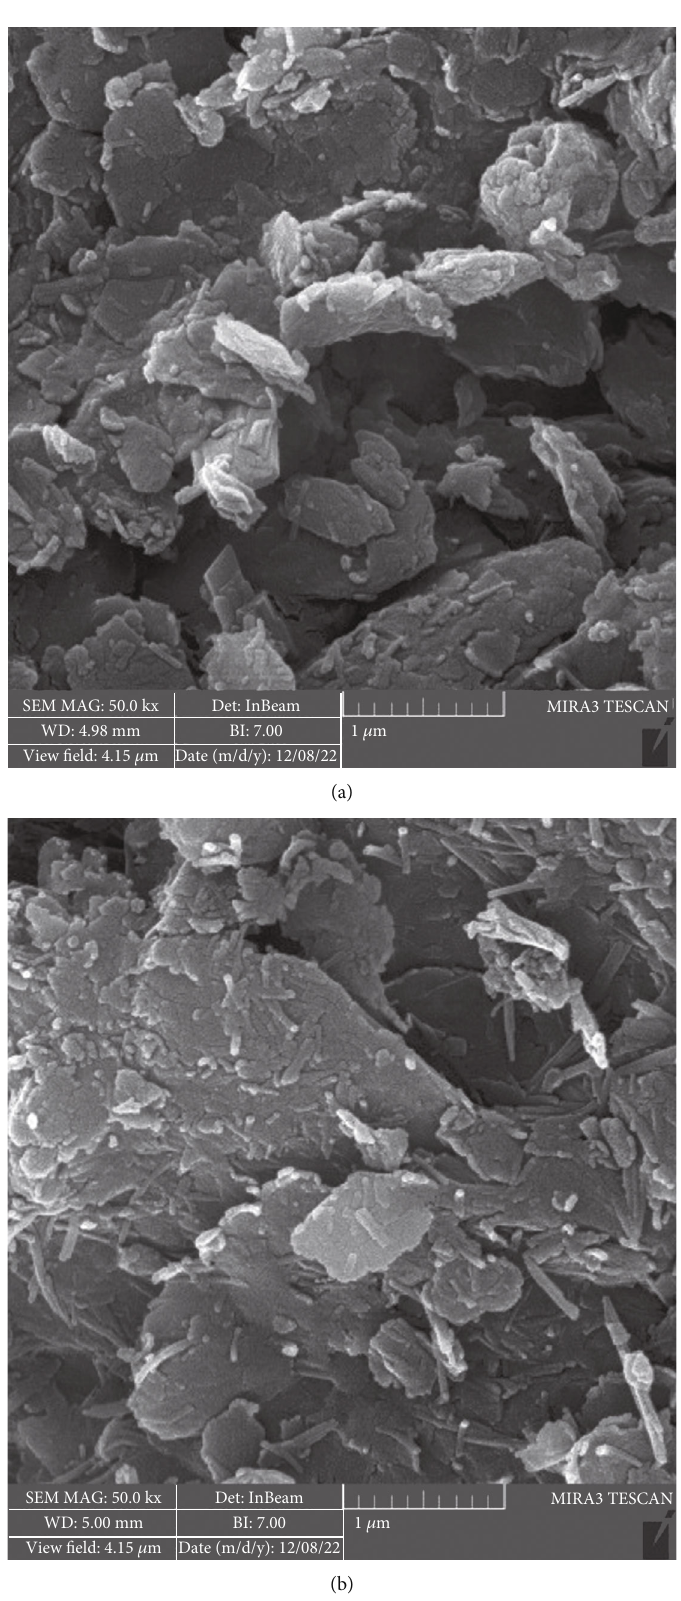
Figure 3: SEM of the TKC: (a) before BF adsorption; (b) after BF